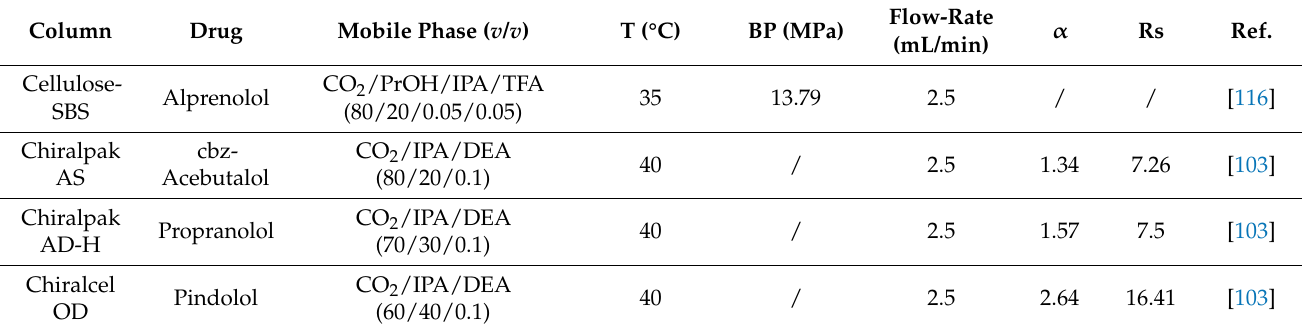
Table 12. Typical results for the enantioseparation of β -blockers in